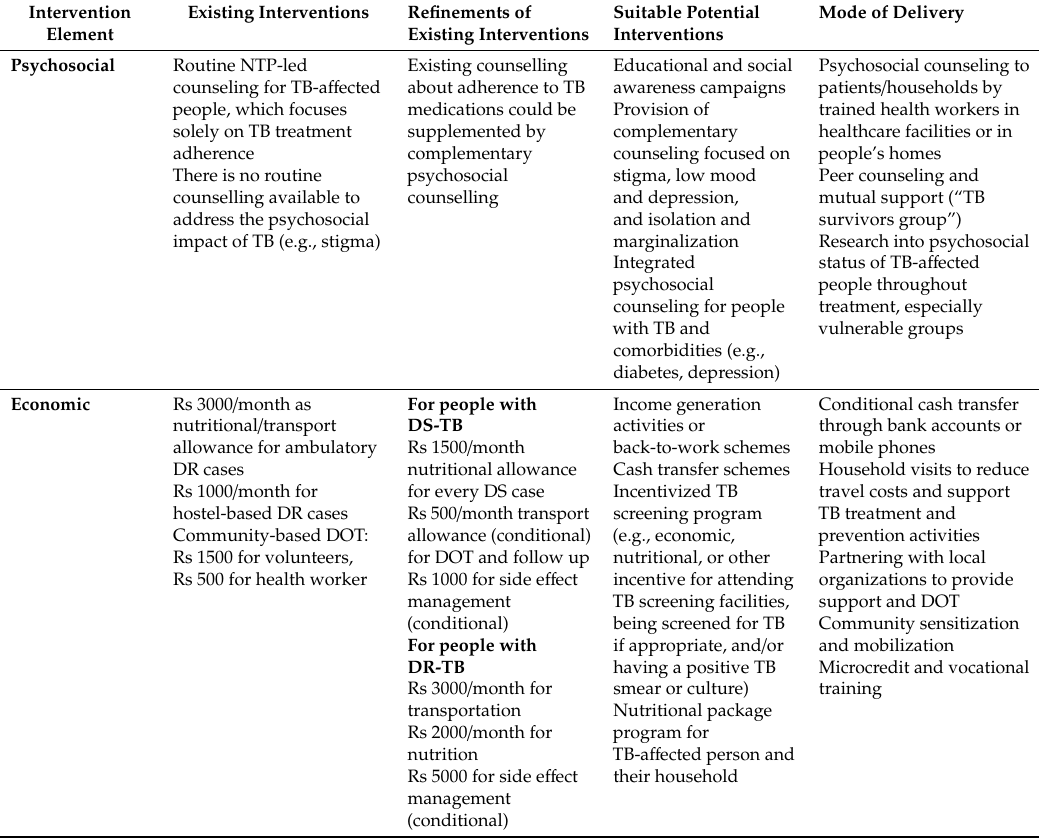
Table 1. Current and potential psychosocial and economic